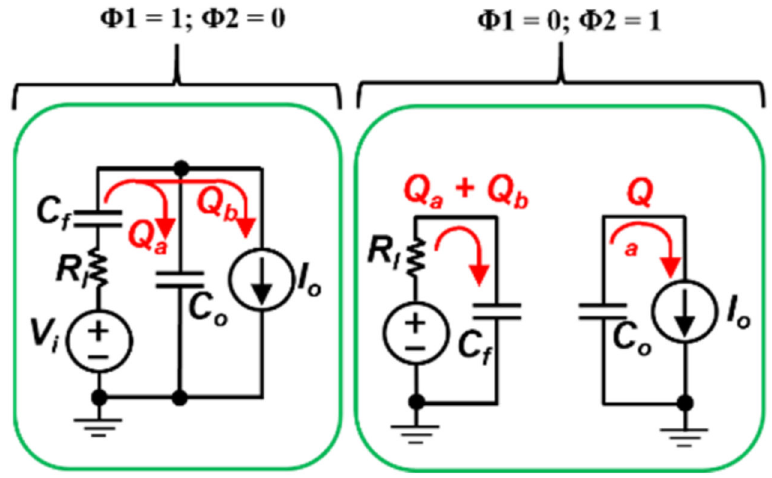
Figure 5. Charge transfer in both phases: Phase 1 ( left ) and Phase 2 ( right ).